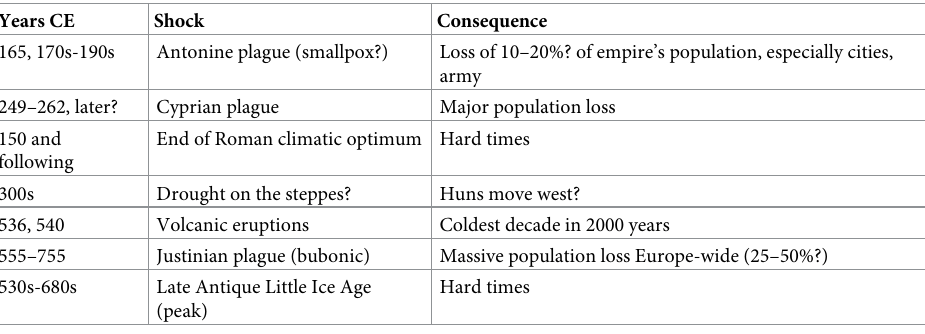
Table 6. Environmental shocks and the fate of